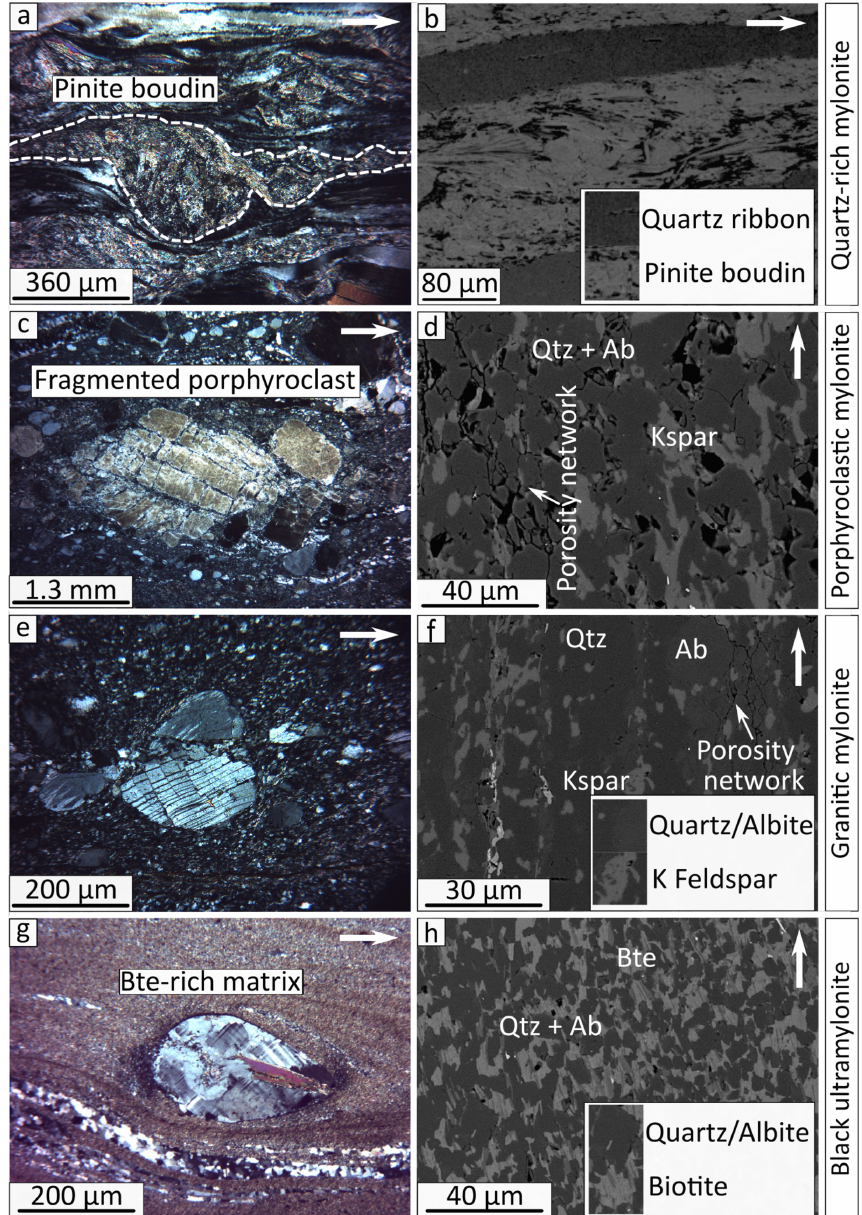
Figure 4. Characteristic microstructure of different Pofadder mylonites (left), with BSE image of fine-grained matrices (right). (a) Pinite pseudomorphing boudinaged cordierite in quartz-rich mylonite. (b) Pinite band bounded by quartz ribbons. (c) Large fragmented porphyro- clast of sericite-altered feldspar in porphyroclastic mylonite. (d) Quartz and/or albite (darker grey), and potassium feldspar (medium grey) in the matrix of porphyroclastic mylonite. Intergranular porosity is black. (e) Fragmented plagioclase porphyroclast in granitic mylonite. (f) Quartz (darkest grey), albite (dark grey) and potassium feldspar (light grey) composing granitic ultramylonite matrix. Intergranular poros- ity is black and muscovite is white. (g) Rounded porphyroclast in black ultramylonite. (h) Well-distributed biotite (light grey) and quartz and/or albite (dark grey) matrix in black ultramylonite. Intergranular porosity is black. Thin-section orientation is indicated with a white arrow directed to the NW in each